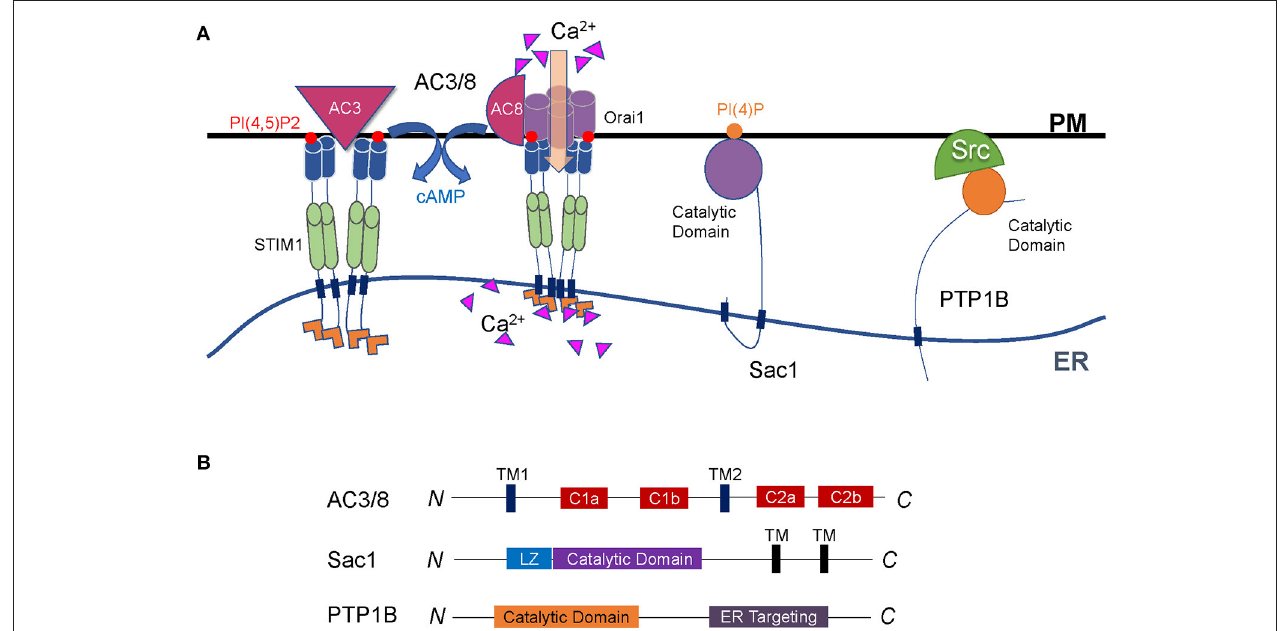
FIGURE 3 | Regulation of cell signaling by enzymes at ER-PM contact sites. (A) Representative illustration of enzymes functioning at the interface between the ER and the PM. Both AC3 and AC8 are located on the PM through multiple transmembrane domains. AC3 interacts with STIM1, and AC8 binds directly to Orai1. They are both regulated by Ca 2 + signals to produce cAMP. Sac1 is a conserved PI(4)P phosphatase anchored to the ER and can dephosphorylate PI(4)P both on the PM and in the ER membrane. PTP1B is anchored to the ER membrane via a C-terminal fragment and dephosphorylates its substrates on the PM through the cytosolic catalytic domain. (B) Diagrams of the enzymes described in A. The major functional domains are shown in each of the